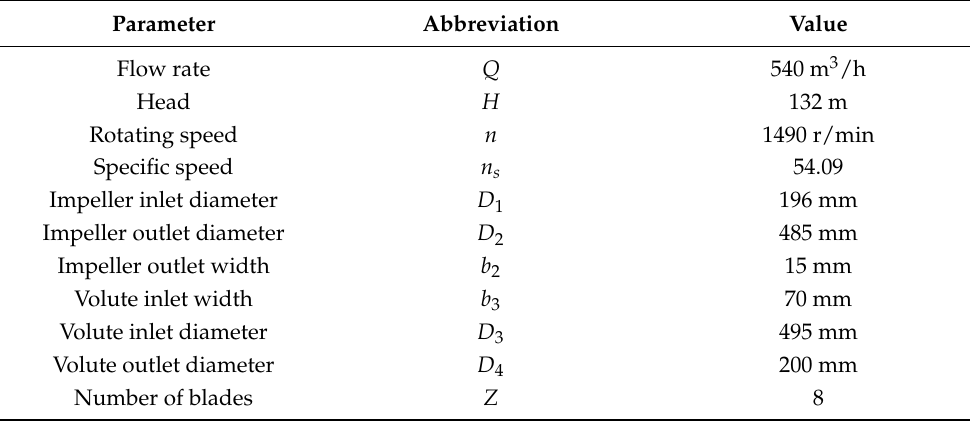
Table 1. Main design parameters of the multi-stage double-suction centrifugal